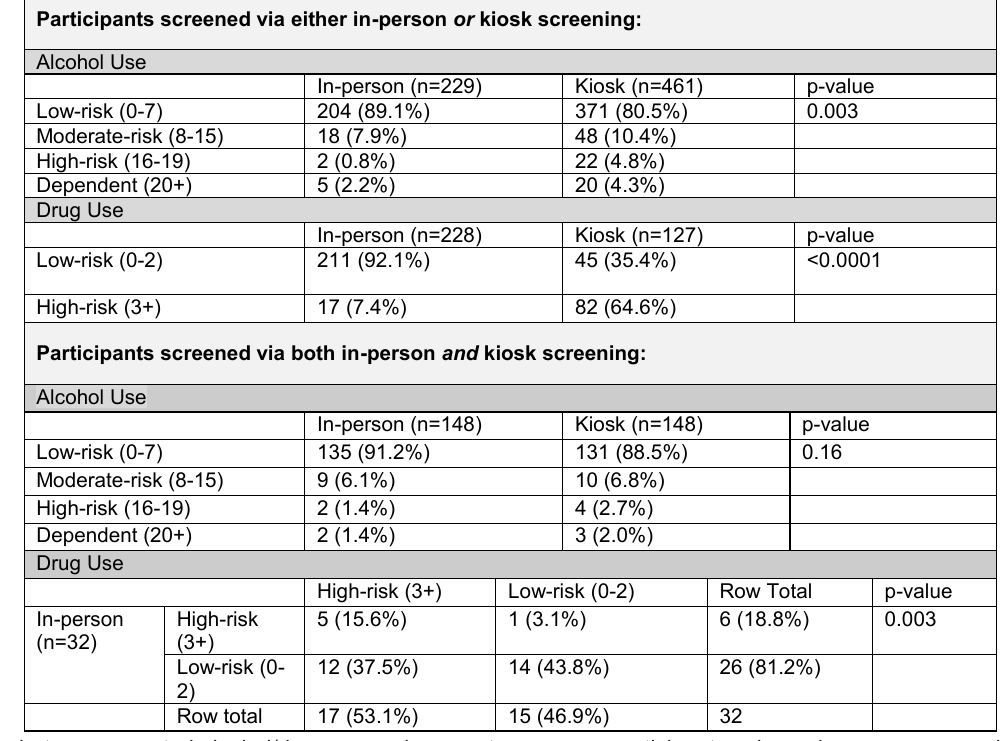
Figure 2 . Relationship between reported alcohol/drug use and survey type among participants using only one survey modality and patients screened via both in-person and kiosk screening.